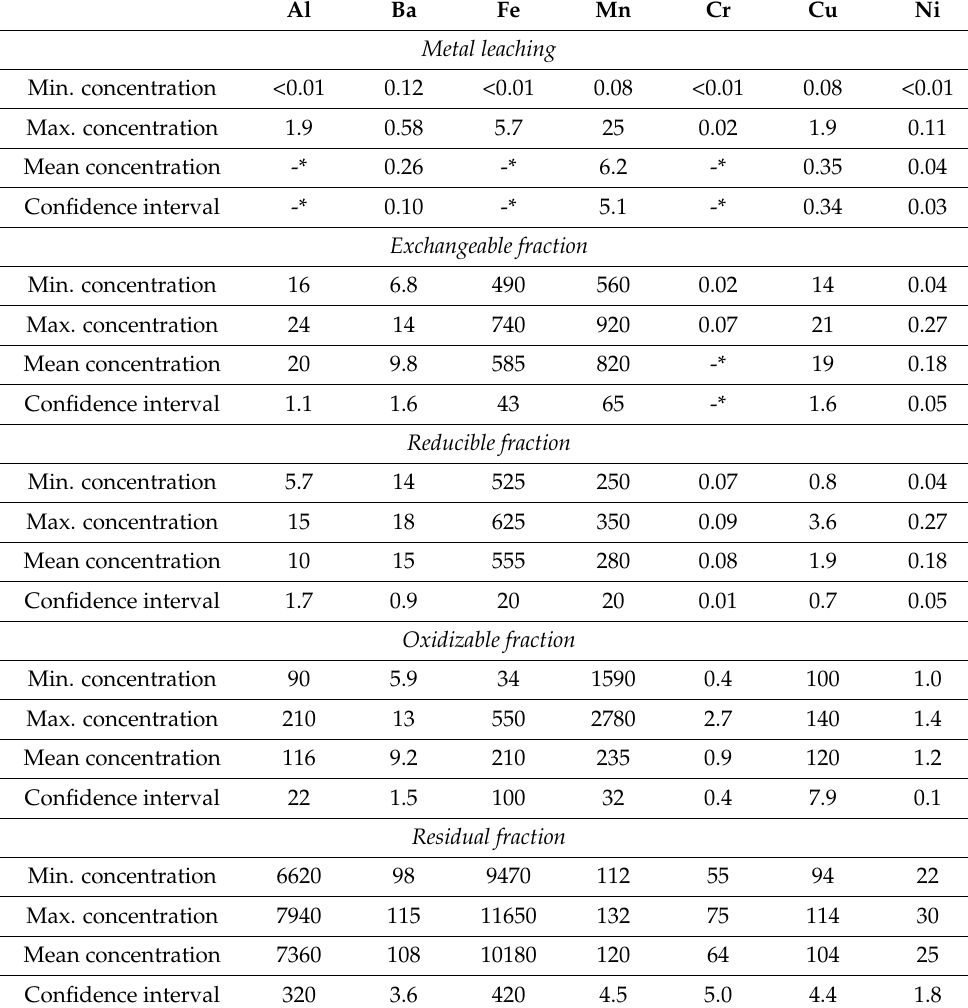
Table 4. The range and mean metal concentrations (mg/kg TS), and confidence interval in the 11 leaching experiments, for the mine tailing–sediment slurry fractions: leaching, exchangeable, reducible, oxidizable and